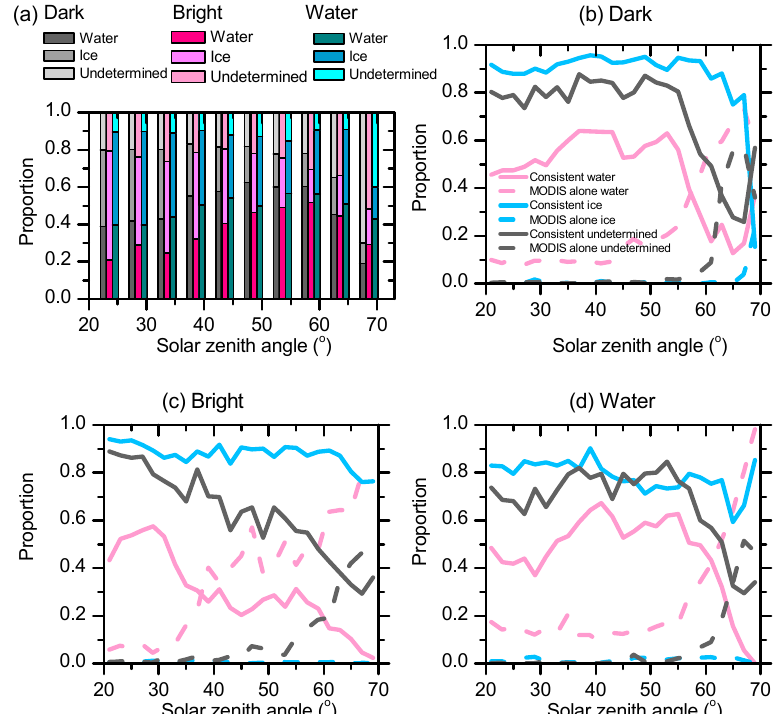
Figure 6. ( a ) The proportion of MODIS cloud phases (water cloud, ice cloud, and undetermined-phase cloud); ( b – d ) The proportion of water, ice, and undetermined-phase clouds over dark, bright, and water surfaces, respectively. Solid lines show the consistent proportion observed by both MODIS and CALIOP, and dashed lines show the non-consistent proportion observed by MODIS alone.